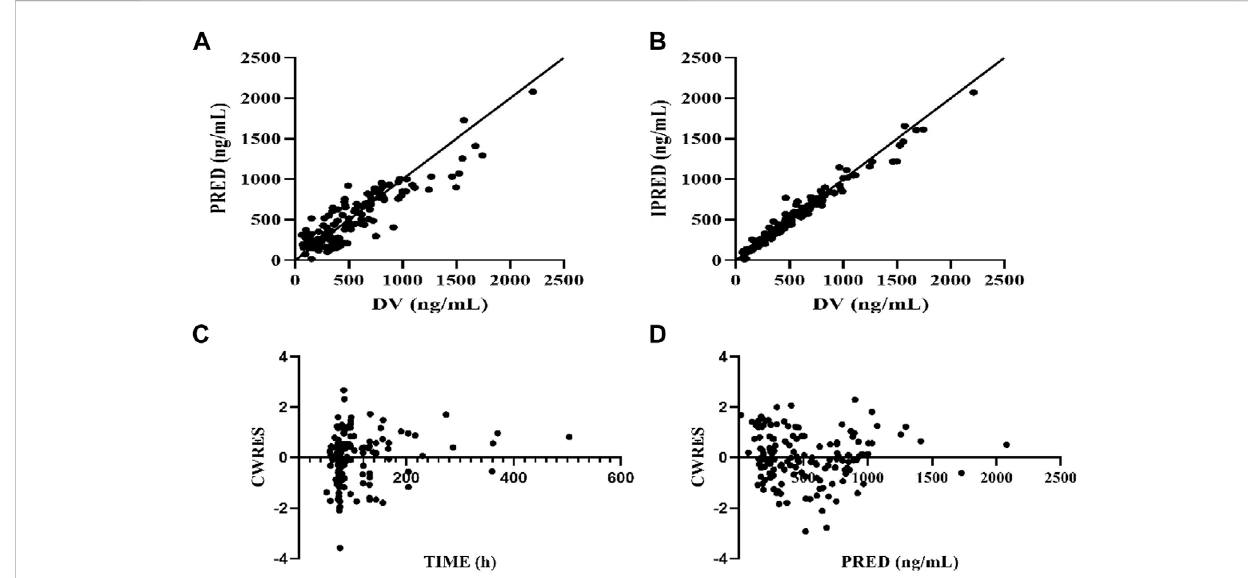
FIGURE 1 Diagnostic plot of fi nal population pharmacokinetic model. (A) Scatter plot of observed values-population predicted values, (B) Scatter plot of observed values-individual predicted values, (C) Scatter plot of conditional weighted residuals — time since initial dose, (D) Scatter plot of conditional weighted residuals-predicted values of the population. The solid line is reference